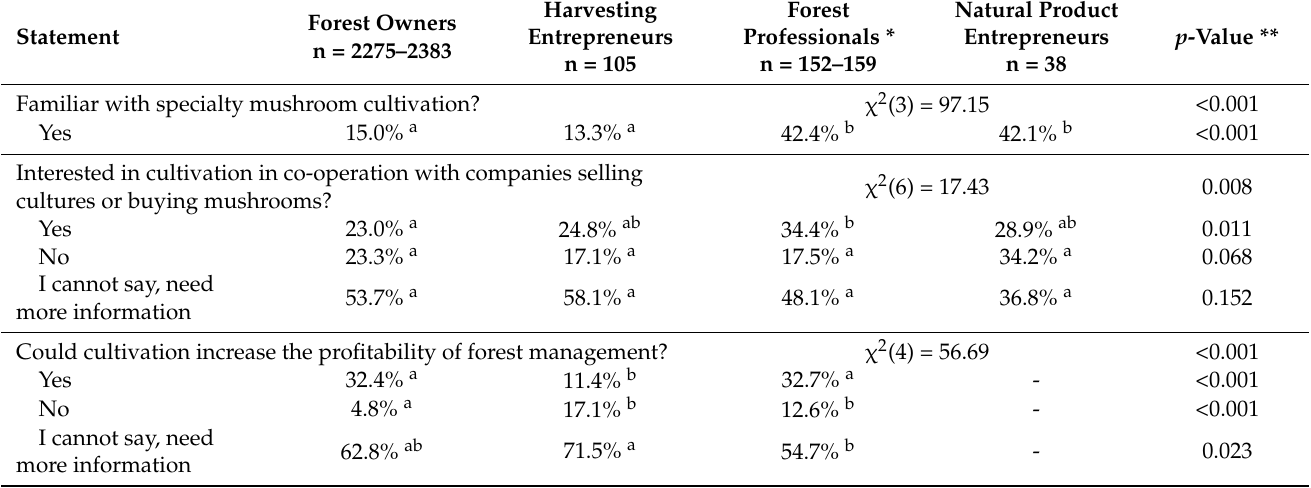
Table 10. Actors’ opinions on specialty mushroom